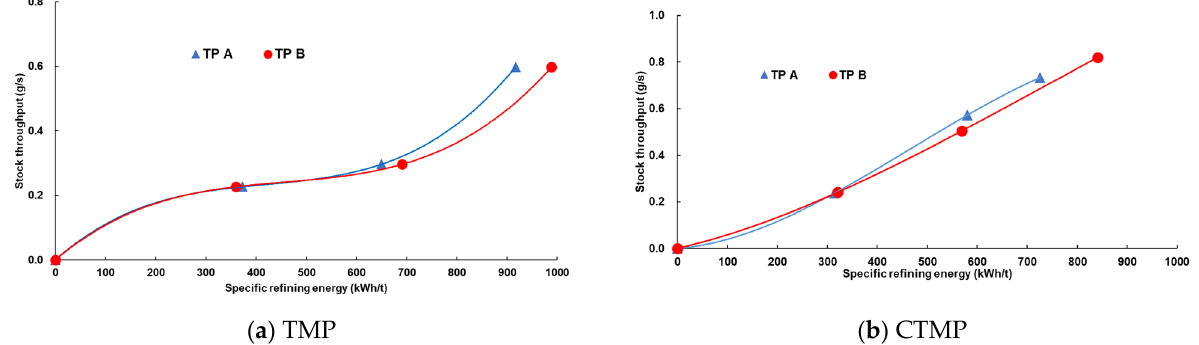
Figure 4. Stock throughput of di ff erent plates with distinctive pa tt erns.